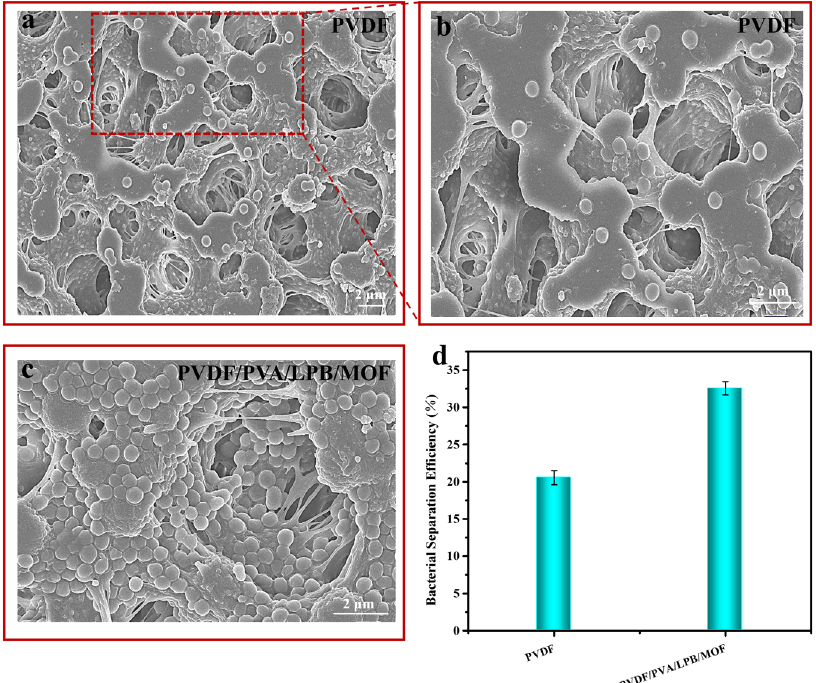
Fig. 6 Isolation of bacteria by PVDF membrane and PVDF/PVA/LPB/MOF membrane. a FE-SEM images after PVDF membrane fi ltration and b further ampli fi ed FE-SEM images c FE-SEM images after the bacterial solution was fi ltered by the PVDF/PVA/LPB/MOF membrane. d The separation ef fi ciency of PVDF and PVDF/PVA/LPB/MOF membranes for bacteria